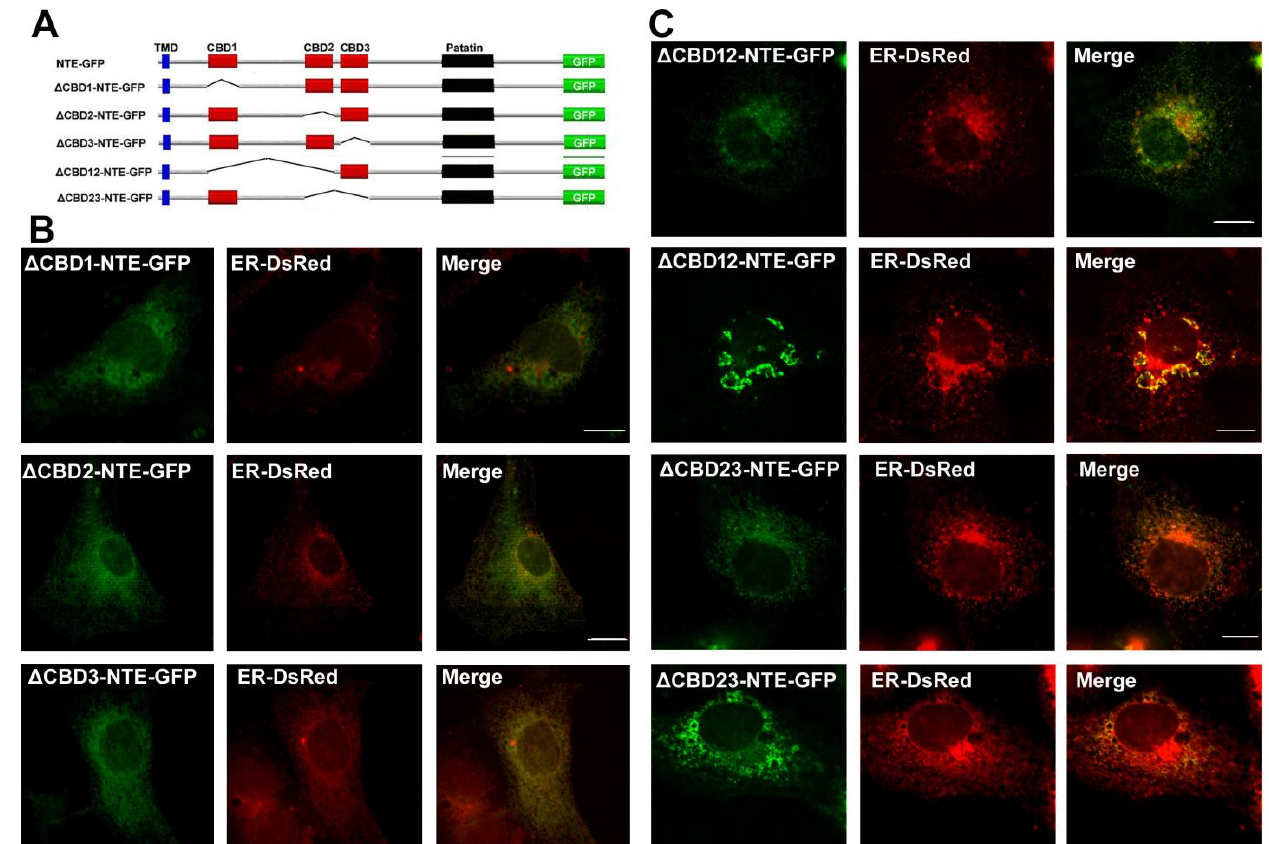
Figure 1. Functional contribution of CBD in NTE to ER targeting and aggregation. ( A ) domain architecture of NTE variants used in this experiment. ( B , C ) subcellular distribution of NTE variants with loss of one ( B ) and two CBDs ( C ). COS-7 cells were cotransfected with NTE-GFP truncation mutants and DsRed-ER, a recombinant DsRed2-tagged marker of the ER, and observed by confocal fluorescence microscopy. Figures are representative of at least three experiments. Scale bars = 10 µm.